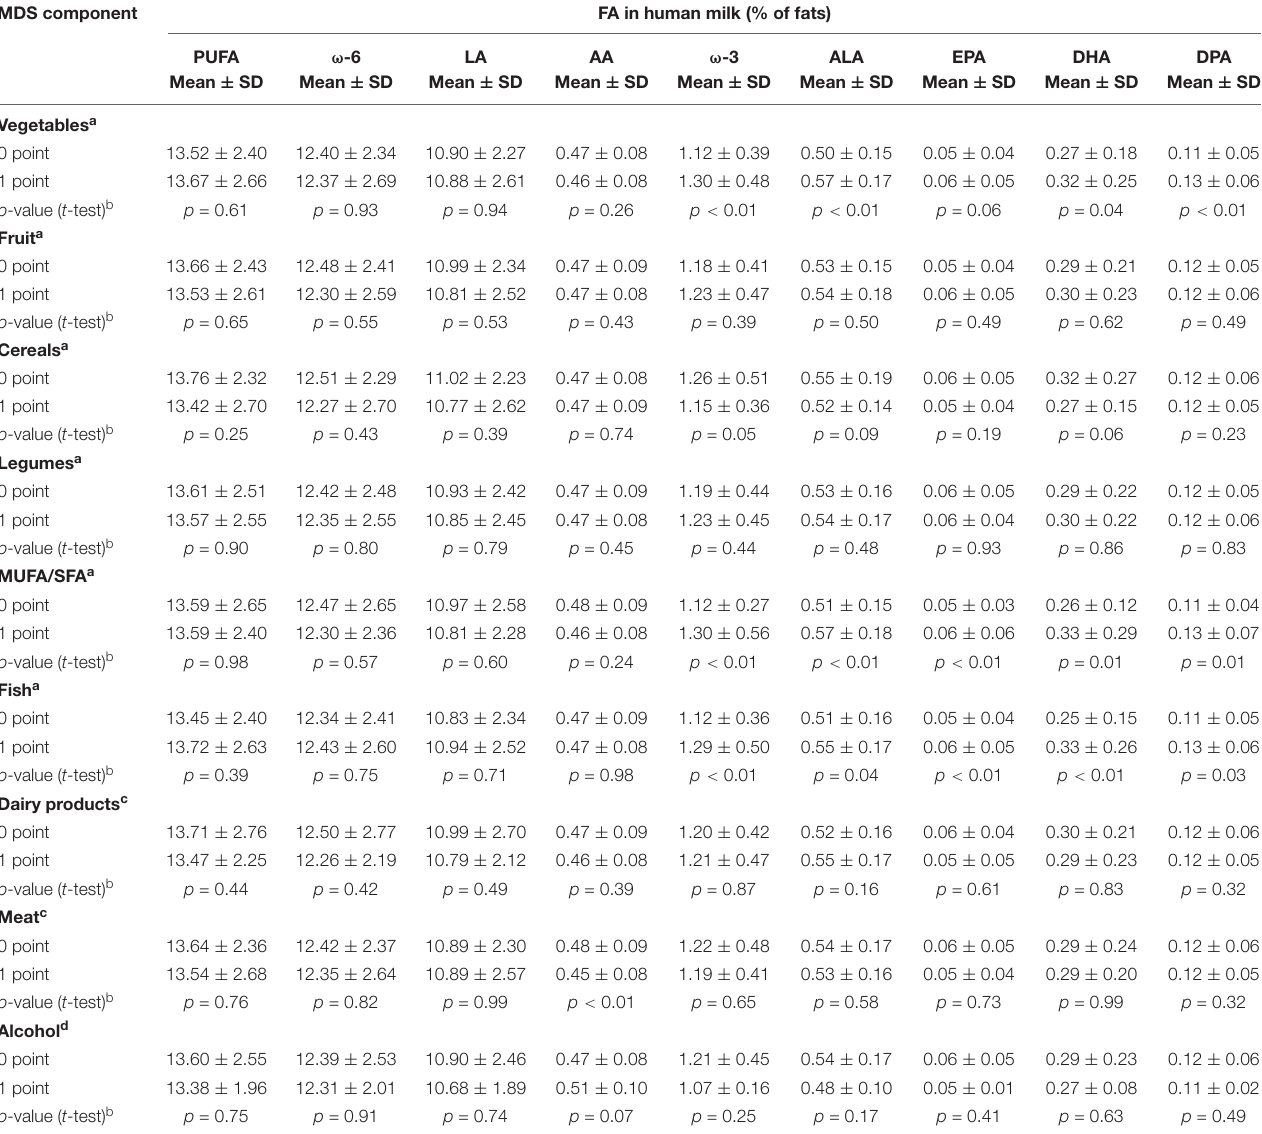
TABLE 6 | Mean and standard deviation contents of major polyunsaturated fatty acids in human milk (expressed as% of fats) according to the adherence of breastfeeding mothers to single components of the Mediterranean Diet Score. MDS component FA in human milk (% of